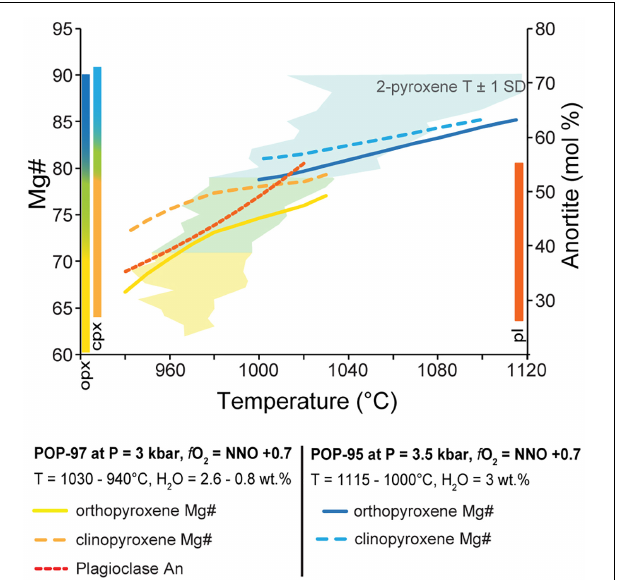
TABLE 2 | Representative whole rock compositions used for MELTS modeling.